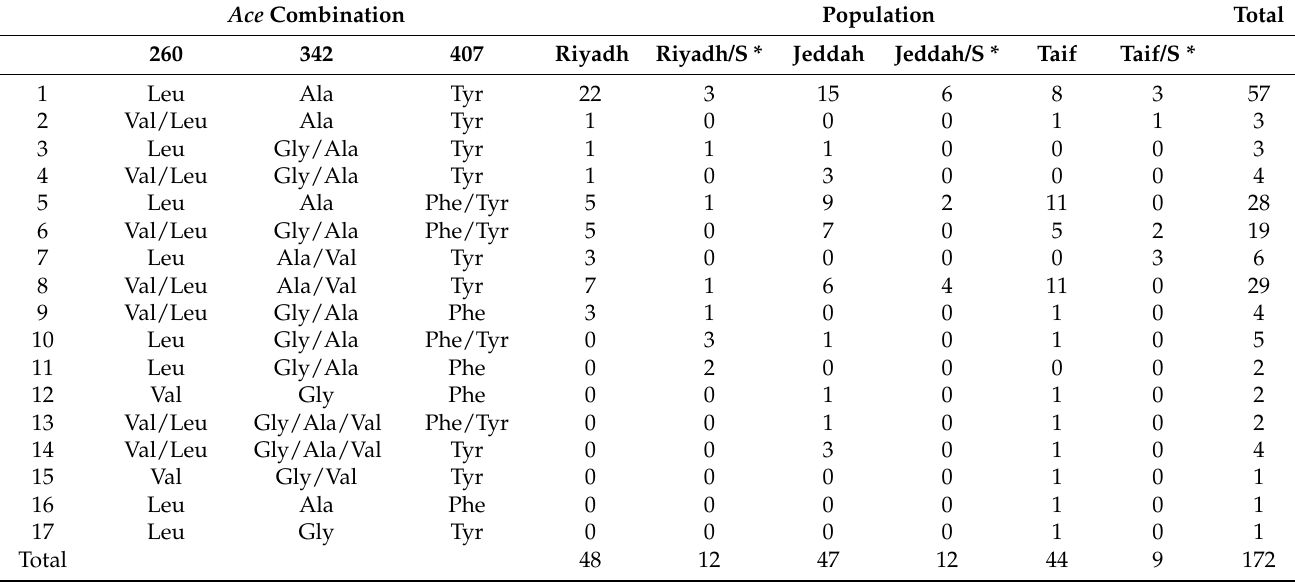
survivors in the Jeddah population showed three combinations that had already been detected in the field population (Table 4). The Taif population had 13 Ace combinations, 9 of which were represented by one individual each, with one sensitive combination (Table 4). The four multi-individual combinations were Val/Leu260 + Ala/Val342 + Tyr407 (11/44), Leu260 + Ala342 + Phe/Tyr407 (11/44), Val260 + Ala342 + Tyr407 (8/44), and Val/ Leu260 + Ala/Val342 + Phe/Tyr407 (5/44). Three out of the four combinations recovered from survivors in the Taif population had already recovered from the field population. Interestingly, the fourth combination, Leu260 + Ala/Val342 + Tyr407 (represented by 33% of the survivors), was not detected in the field population. Overall, the most frequent combination, Leu260 + Ala342 + Tyr407, was found to be strongly, positively correlated with PM-RRs for the three populations ( r = 0.92, p = 0.078). Table 4. Combinations of three mutations at amino acid positions 260, 342, and 407 of AChE polypeptide, associated with insecticide-resistance, recovered from house flies collected from three slaughterhouses in Saudi Arabia, along with their counterparts, F1 survivors, exposed to pirimiphos- methyl insecticide. Population